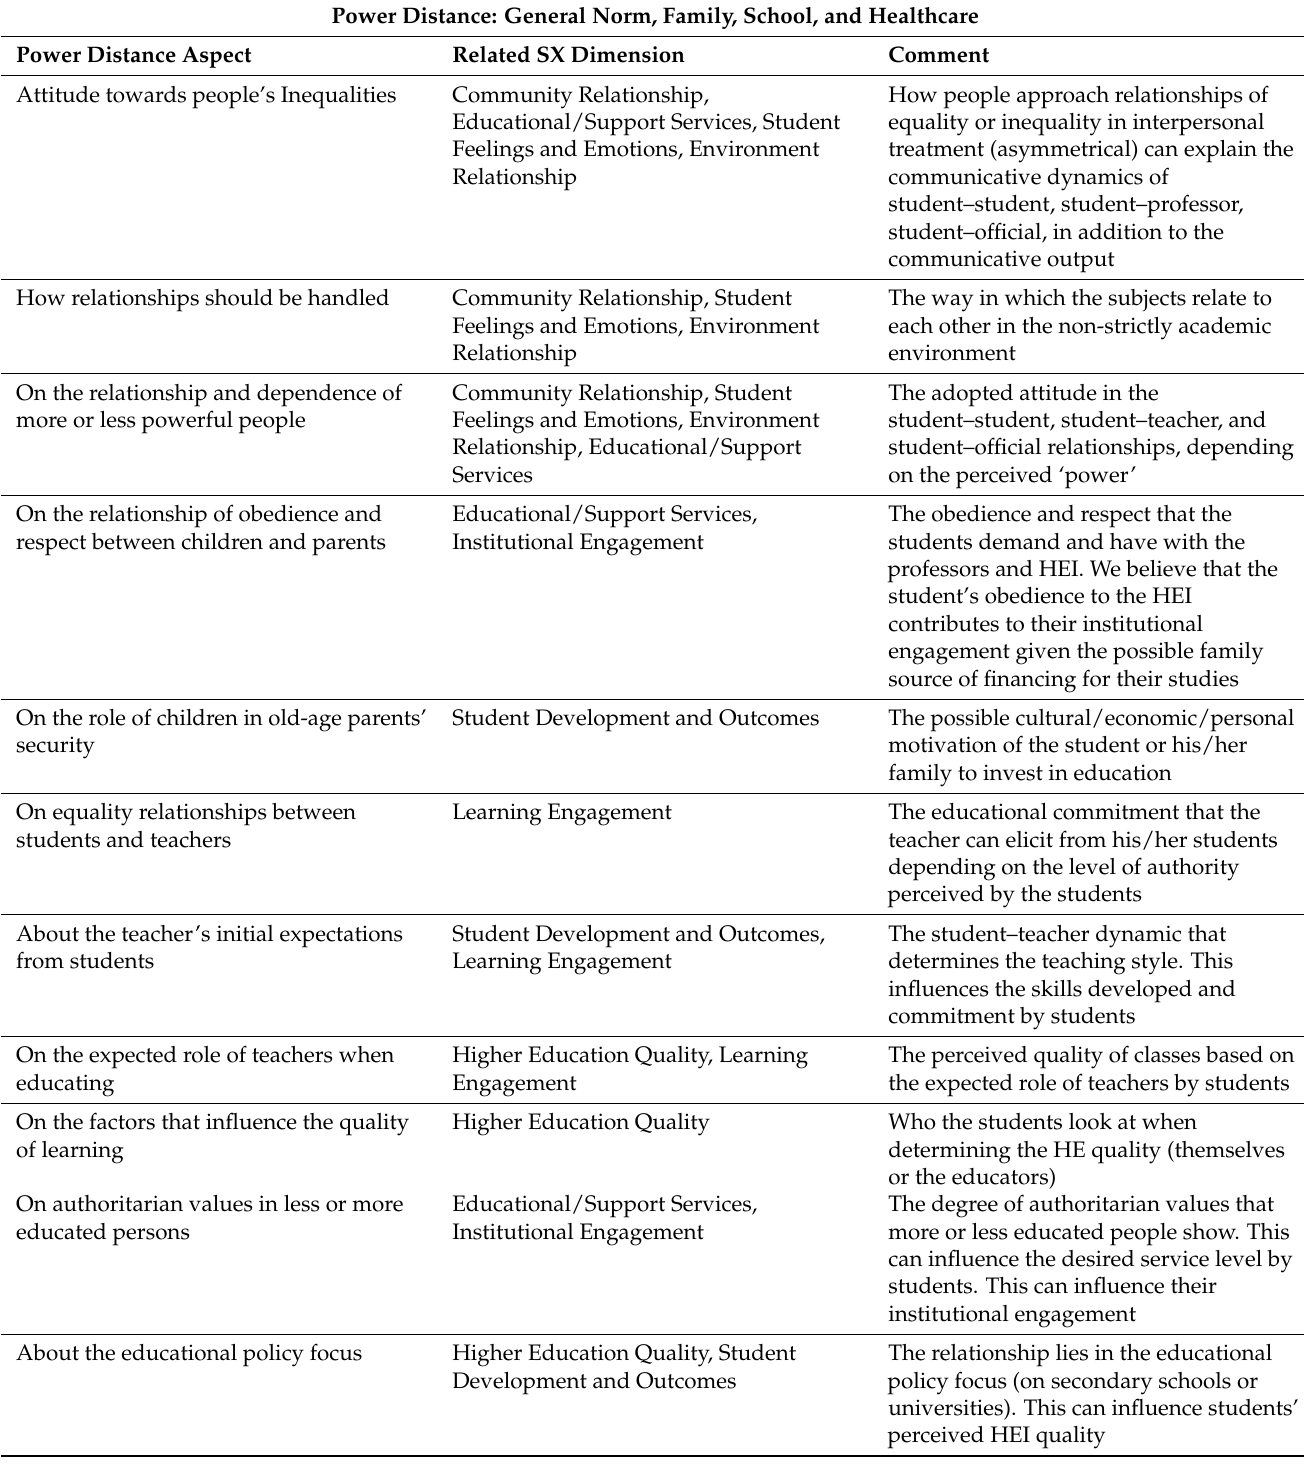
Table 2. General norm, family, school, and healthcare aspects of power distance in